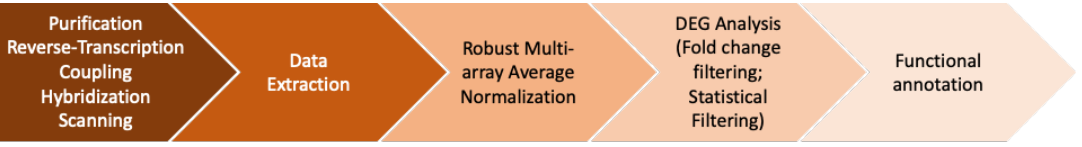
Figure 3. Expression analysis of differentially expressed genes (DEGs) in response to X. oryzae pv. oryzae race K2 interaction. ( A ) Heat-map showing the expression patterns of all differentially expressed genes in four libraries. From left to right, the four columns respectively show the expression of genes in the non-inoculated Dongjin (DJ; susceptible type), inoculated DJ, non-inoculated Jinbaek (JB; resistant type), and inoculated JB. Green, black, and red respectively indicates low, no change, and high expression levels of genes. ( B ) The number of DEGs in treated JB (JB_48 vs. JB_0), treated DJ (DJ_48 vs. DJ_0), and a combination of both. Dark bar represents up-regulated; gray bar represents down-regulated DEGs. ( C ) Venn diagram showing the number of genotype-specific (unique) genes and overlapping genes.